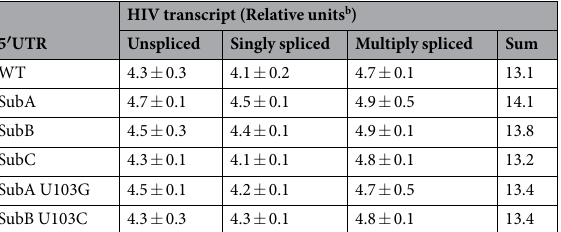
Fig. S1. Cells transfected with each molecular clone were briefly incubated in medium depleted of cysteine and methionine, halting new protein synthesis, while allowing for ribosome runoff and the loading of preinitiation complexes to activated mRNA templates. Next, the cultures were supplemented with 35 S-methionine and cysteine ( 35 S-cys/met) to support new protein synthesis from activated mRNA templates. Newly synthesized polypeptides were isolated by immunoprecipitation (IP) with specific antisera, subjected to SDS-PAGE and phosphorimaged to quantify 35 S-incorporation to specific polypeptide. The 35 S-cys/met incorporation into Gag measured the trans- lation activity of HIV 5 ′ UTRs. (Fig. 2 and Fig. S2). Different activity of mRNA templates was resolvable within 45 min and IP controls indi- cated that by 60 min, the concentration of Gag-specific antiserum began to limit sensitivity of the assay (data not shown). Sufficient statistical power was achieved by harvesting samples at three 15-min intervals in multiple replicate experiments with the molecular clones. Gag synthesis during the successive time points was similar between WT and the SubA, SubB, SubC 5 ′ UTRs, indicating the translation rate of these mRNAs remained similar, despite different stabilities of U5:DIS pairings. By contrast, SubA U103G and SubB U103C 5 ′ UTRs significantly increased 35 S-incorporation to Gag, indicating these 5 ′ UTR conformations increased the rate of translation (Fig. 2a and b).